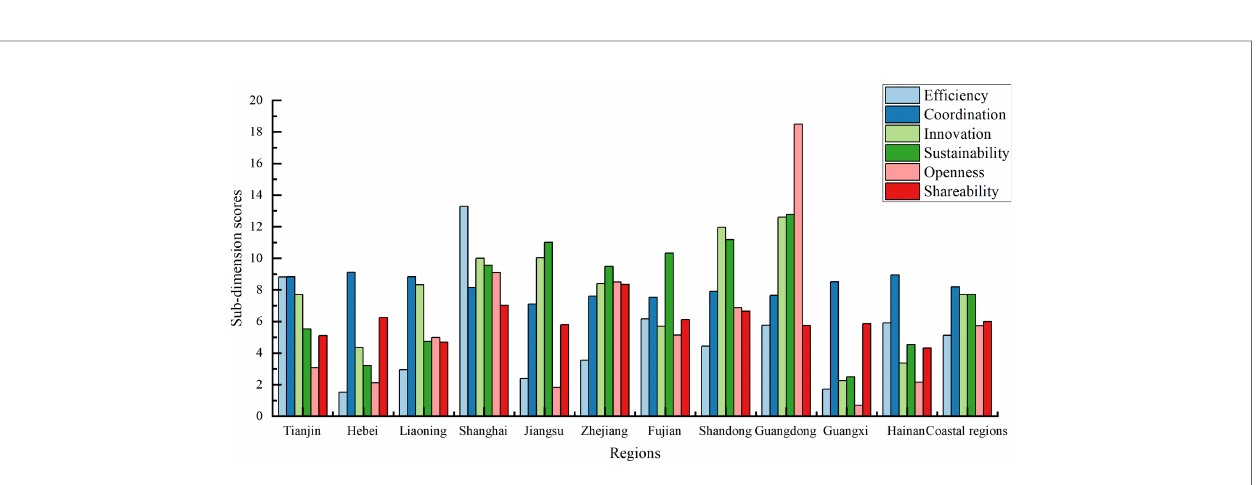
FIGURE 3 | Average scores of the six sub-dimensions of the marine economy in 11 coastal provinces (cities and districts) from 2010-2018.